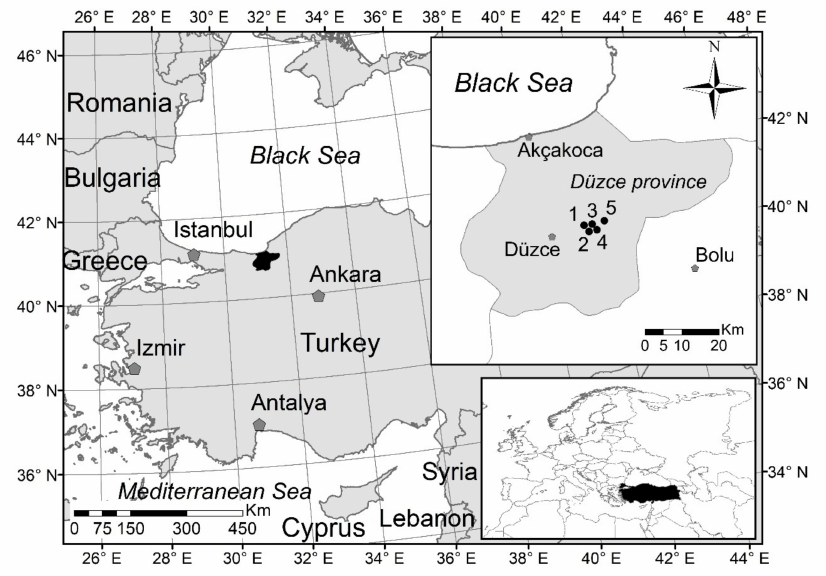
Figure 1. Locations of the permanent research plots with Fagus orientalis Lipsky forest stands in the Düzce province in the Black Sea Region of